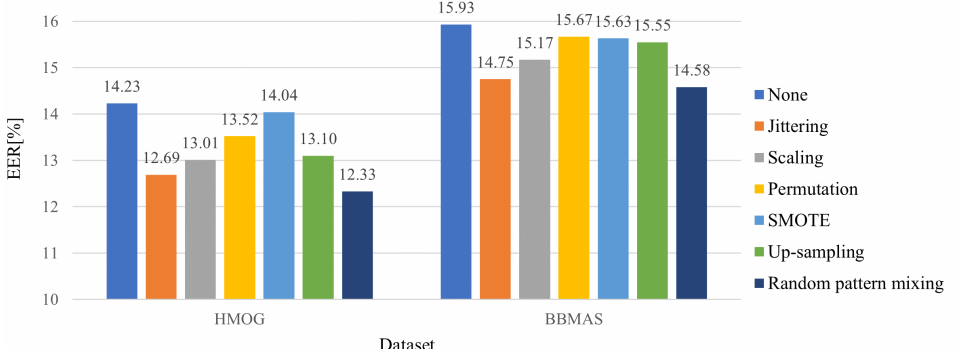
Figure 6. Averaged EERs ( % ) against only unseen impostors for different data augmentation